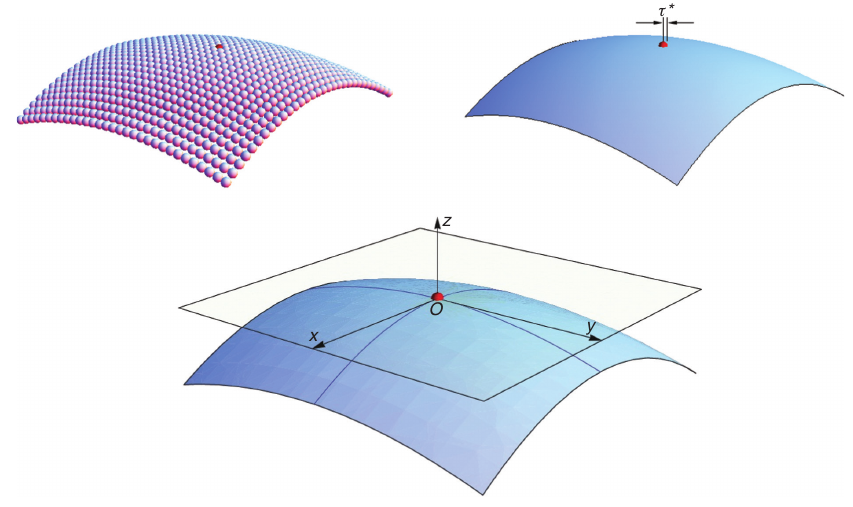
Figure 8 The “inner particle/curved surface” interaction